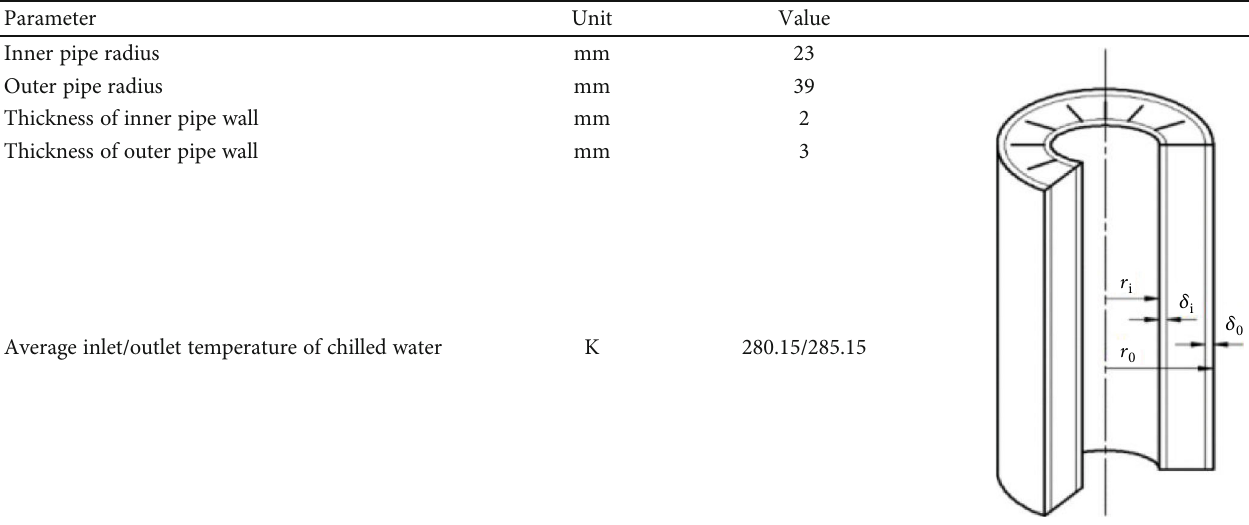
Table 5: Basic values of the parameters for the sewage double-pipe heat